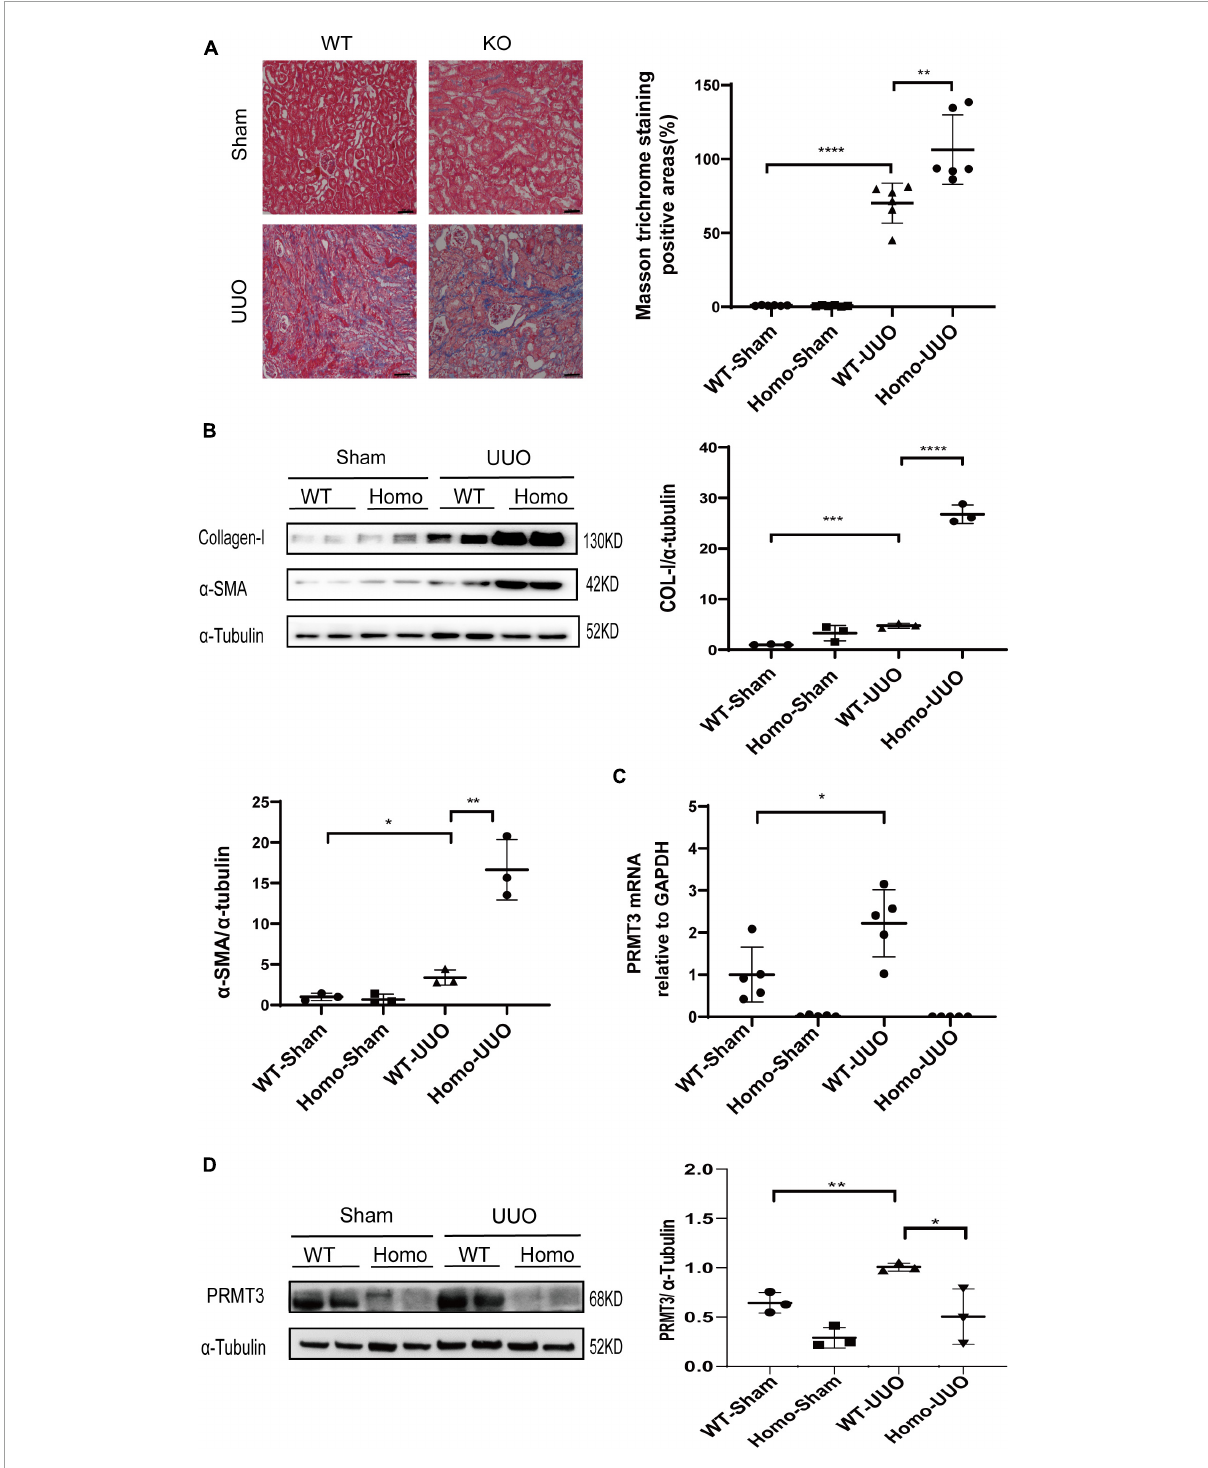
FIGURE1 Knockout of Prmt3 promotes renal fibrosis in obstructed mouse kidneys. Wide type (WT) or homozygous (Homo) Prmt3 mutant c57 mice received sham or UUO operation and were sacrificed at day 14 ( n = 9–10 mice per group). (A) Renal fibrosis was assessed by Masson’s trichrome staining ( n = 6–7 mice per group). Bars, 100 µ m. (B) The expression of α -SMA and collagen-I were analyzed by Western blotting. (C,D) The expression of PRMT3 were analyzed by qPCR or Western blotting. One representative of at least three independent experiments is shown. Data represent mean ± SD. One-way ANOVA was used and comparison between two groups was performed by unpaired student t -test. * P < 0.05; ** P < 0.01; *** P < 0.001; **** P <